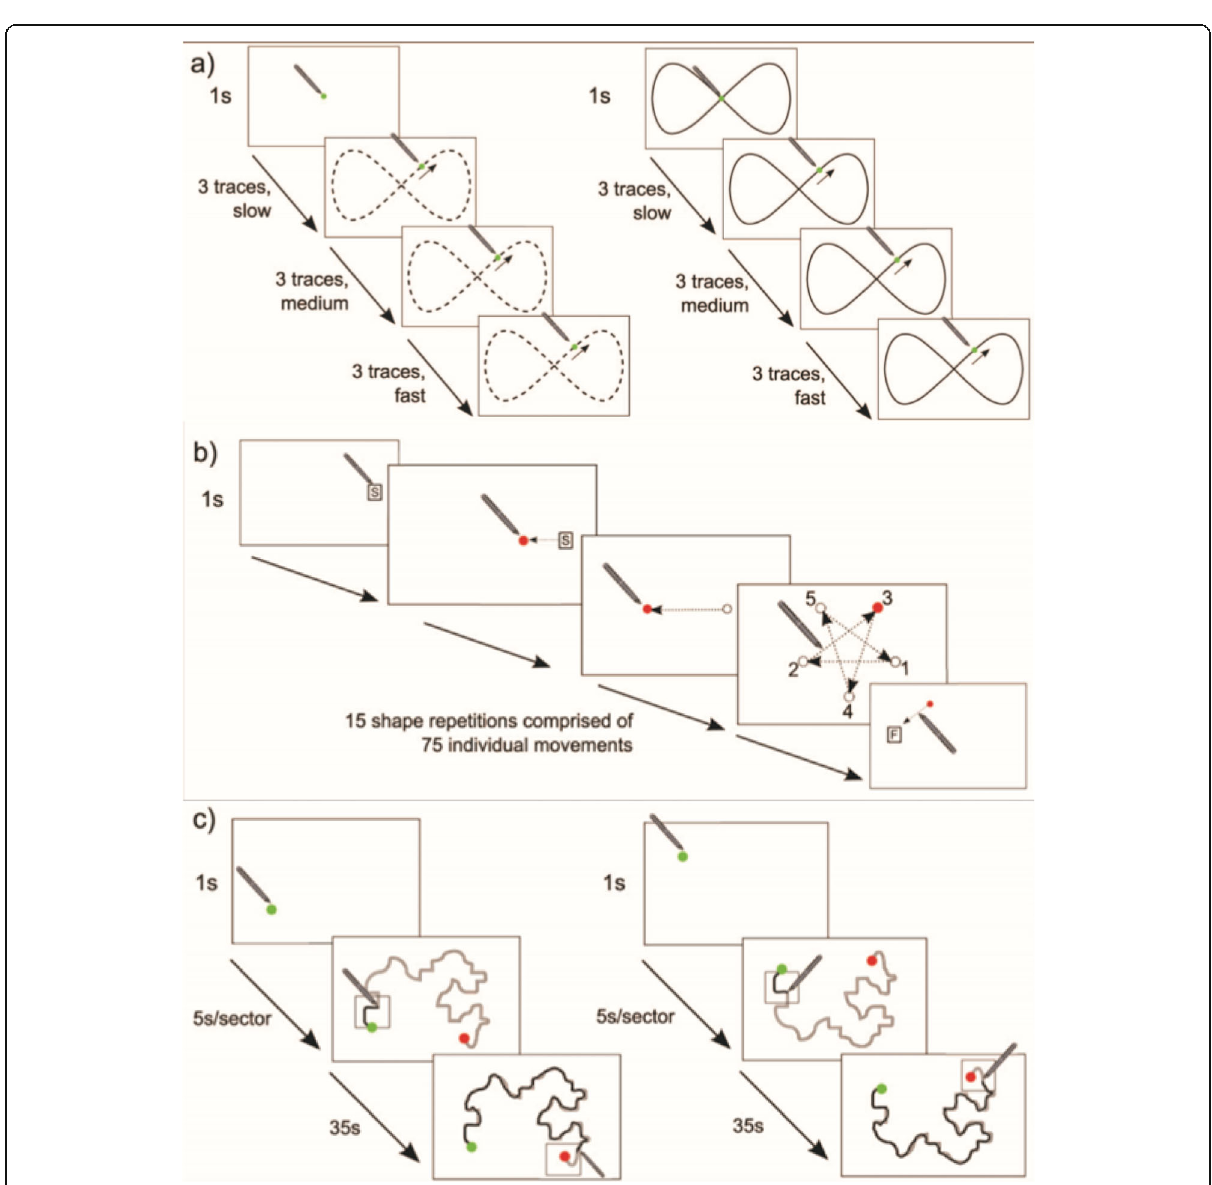
Fig. 1 Sensorimotor Battery: a Tracking, b Aiming and c Steering, taken from Flatters et al. (2014). a Tracking: Left demonstrates the without- guide tracking trial (the dotted line indicates the pattern of movement, but participants did not see this line). Right shows the tracking trial with a guide. b Aiming: Arrows demonstrate direction of movement participants made but this is not visible to the participant. The 4th image shows the repeated movements that the participants made, with the numbers demonstrating which dot appeared in which sequence. c Steering: Left shows tracing path A and right shows tracing path B. The square box is the ‘ pace ’ box and the thick black lines demonstrate the pathway area that participants were expected to stay